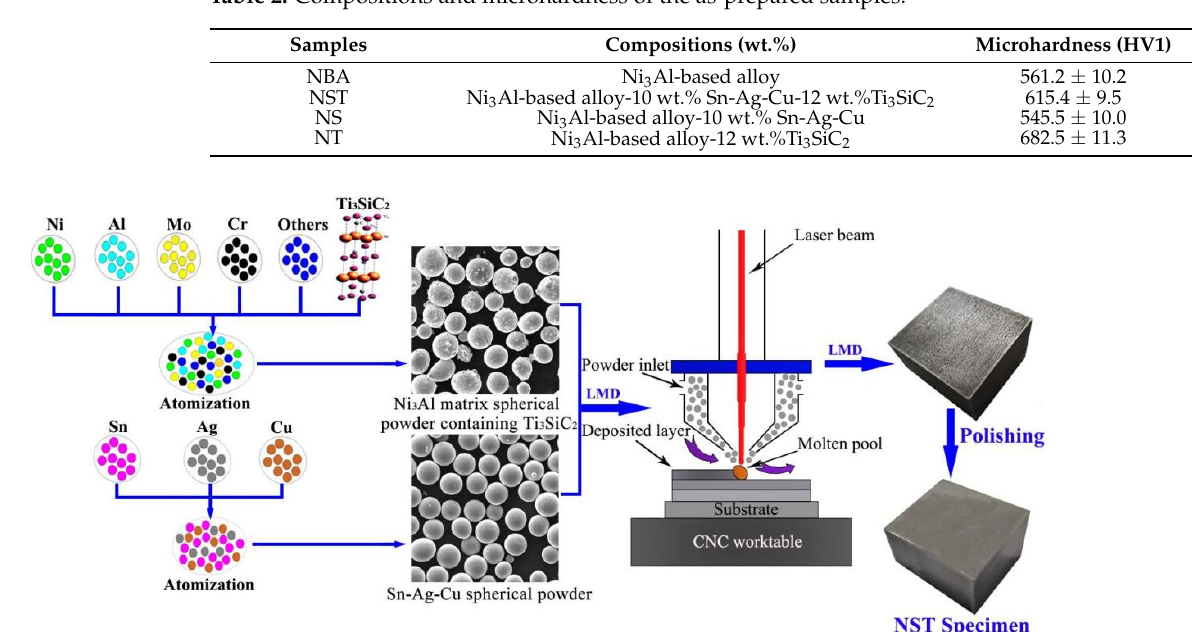
Figure 1. The fl ow chart for the preparation process of NST via LMD. Figure 1. The flow chart for the preparation process of NST via LMD. Table 2. Compositions and microhardness of the as-prepared samples. Table 3. Process parameters for laser-melting